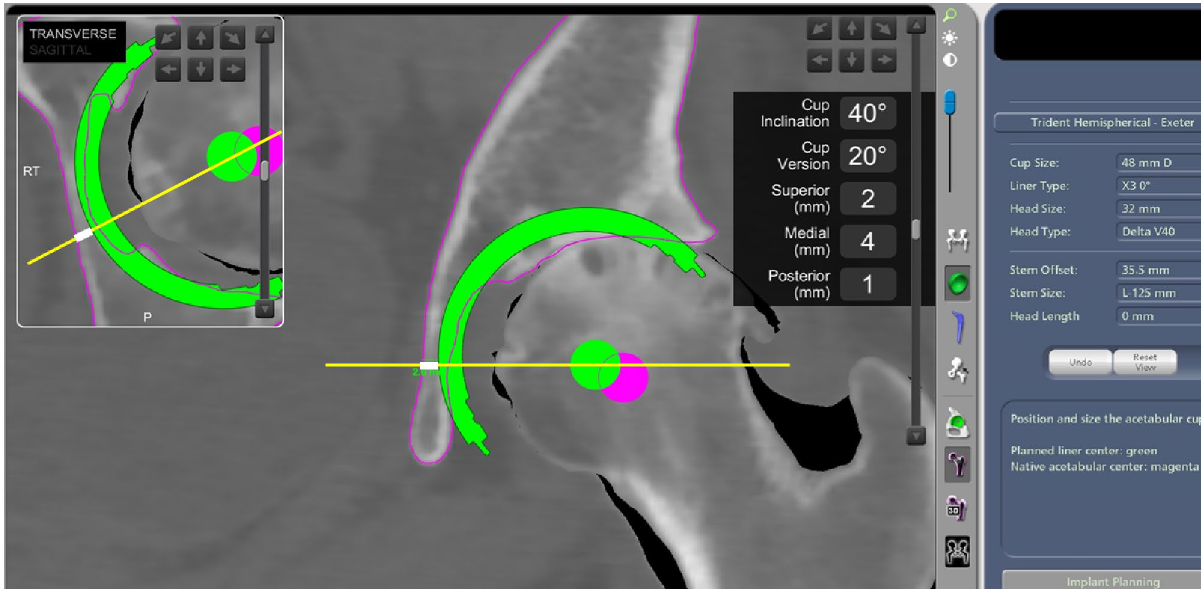
Figure 2. Preoperative cup positions are measured on the MAKO workstation. White lines indicate the distance between the outer edge of the cup and the medial edge of the acetabulum in axial and coronal views.